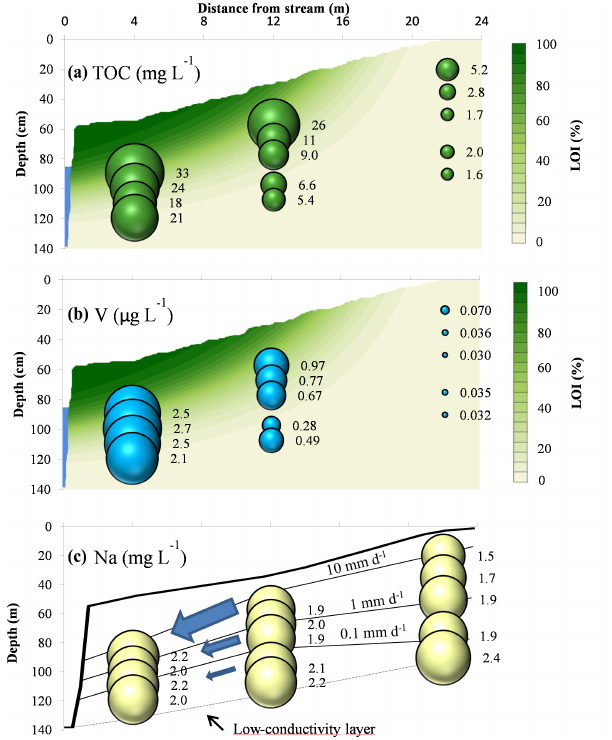
Figure 2. Average soil water and groundwater concentrations of TOC (a) , vanadium (b) and sodium (c) in the investigated transect. The area of the bubbles is proportional to the concentration, which in turn is given next to each bubble. The background illustrates the loss on ignition (LOI, %) in the two upper examples. The bottom subplot illustrates the approximate groundwater levels at different stream discharge based on Laudon et al. (2004). The distance from the stream is measured along the flow pathway of the